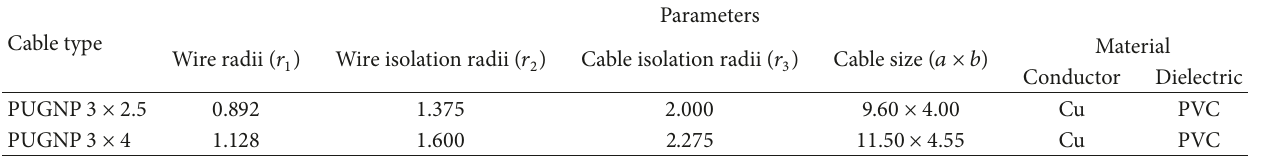
Table 5: Geometrical (mm) and material parameters of cables without air gaps.